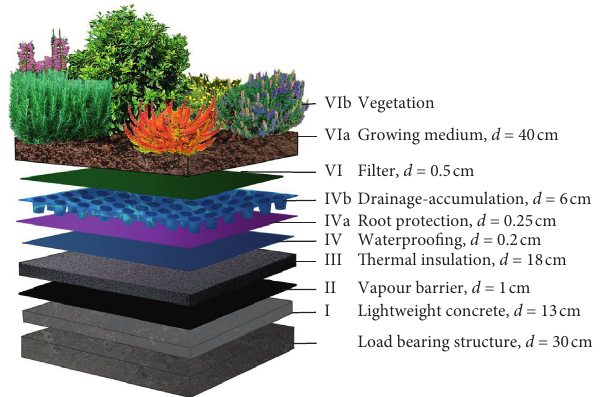
Figure 2: Intensive green roof layers (the figure is created by authors upon data collected from cost estimate for the building under